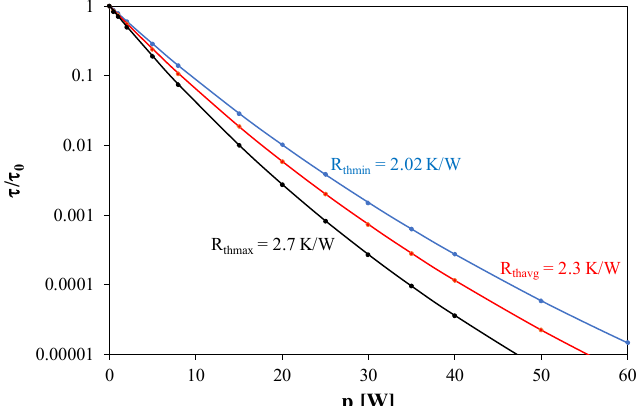
Figure 18. Relative change in the transistor lifetime depending on the dissipated power P D for the BLC10G22LS-240PVT transistor.